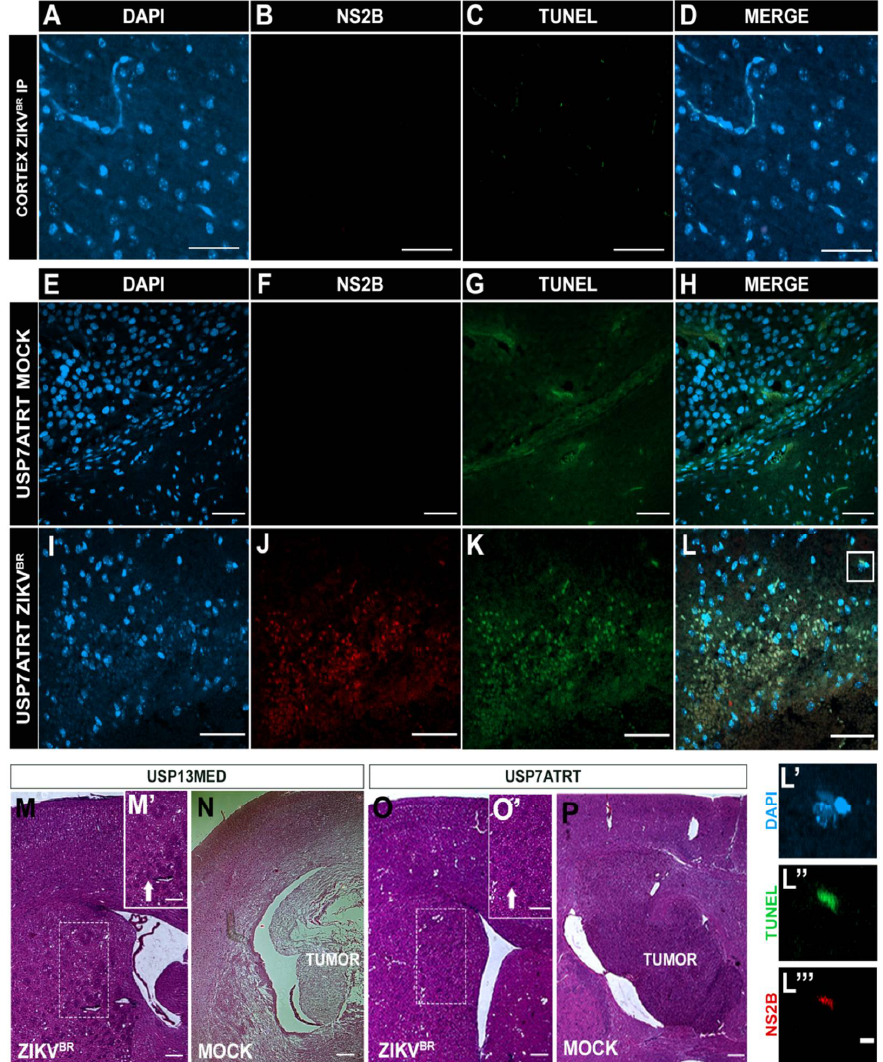
Figure 3. Histological analysis of mice bearing intracranial embryonal CNS tumor after ZIKV BR serial treatment through systemic injections. ( A ) Immunolabeling positive of DAPI (blue), ( B ) cell death (TUNEL, green), ( C ) nuclei ZIKV BR (NS2B, red), and ( D ) the merged channels (MERGE) from the cerebral cortex and ( E – L ) tumor edge of USP7ATRT tumor-bearing mice after systemic ZIKV BR /MOCK injections. Scale bar, 50 µm. Split channels co-located by DAPI ( L’ ), TUNEL ( L’’ ) and NS2B ( L’’’ ). Scale bar, 10 µm. Histological analysis by hematoxylin and eosin stain from the brain of USP13MED tumor- bearing mice after ICV ZIKV injections ( M ), MOCK ( N ), and from USP7ATRT ICV ZIKV treated ( O ) and untreated tumor- bearing mice ( P ), highlighting the pericellular edema ( M’ , O’ , white arrow). Scale bar, 200 µm. Since we observed no survival improvement in mice bearing intracranial USP13MED cells after systemic injection, we questioned if intratumoral ZIKV BR injections can show similar effectiveness as shown in the subcutaneous tumor model (Figure 1B). So, we decided to investigate the effect of intracerebroventricular (ICV) ZIKV treatment, using a virus internalization method that mimics an intratumoral injection for embryonal CNS tumors. For that, the orthotopic xenograft animal model in Balb/c nude mice previously described by our group [7] with USP13MED and USP7ATRT cell lines was used to evaluate the ZIKV BR oncolytic effect with intracerebroventricular (ICV) multiple